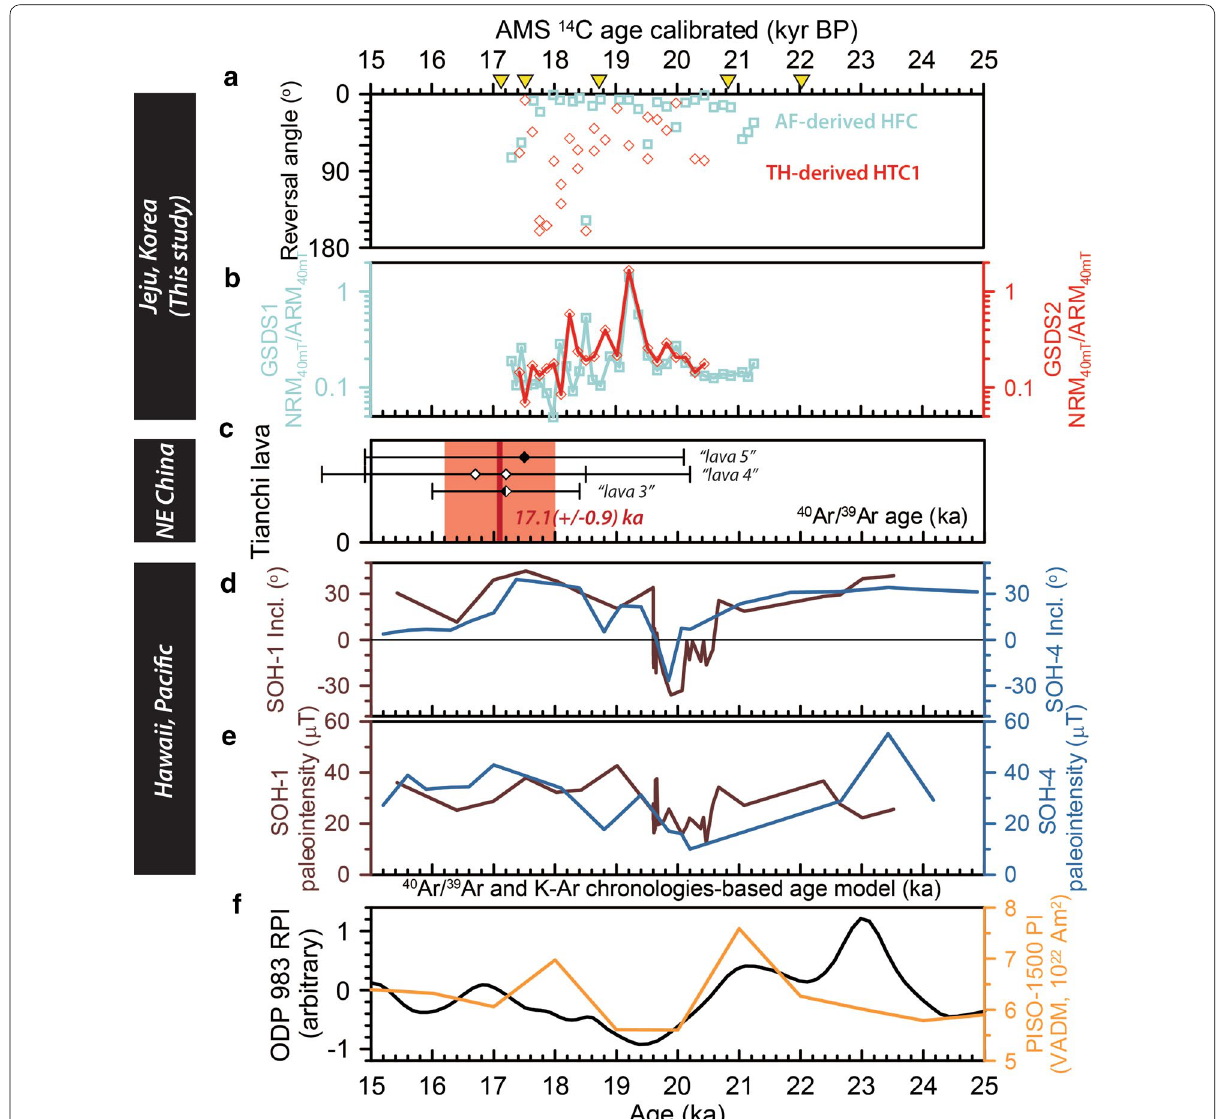
Fig. 13 Comparison of paleomagnetic data with anomalous directional features during 15–25 ka between the GSDS site (this study) and other dif‑ ferent sites. a The GSDS1‑AF‑derived HFC and the GSDS2‑TH‑derived HTC1 directional changes, expressed as the reversal angle (the angle between the paleomagnetic direction and the direction of today’s axial dipole field at the GSDS site) through time with our inferred age‑depth model. Yellow reversed triangles indicate AMS 14 C dates directly determined by Lim et al. (2015). b NRM 40mT /ARM 40mT ratio (possible RPI proxy) variations through time with our inferred age‑depth model in the GSDS site. c 40 Ar/ 39 Ar chronologies with the weighted mean of 17.1 0.9 (2 σ ) ka (a red line and ± box) by Singer et al. (2014b) from the Tianchi comenditic lava sequence where both excursional directions and low absolute paleointensities were reported by Zhu et al. (2000). The individual age data, with 2 σ uncertainties (error bars), are shown as open, half‑filled, and filled diamond sym‑ bols indicating reversed, transitional, and normal polarities, respectively. d , e Temporal variations of paleomagnetic inclination and paleointensity retrieved from SOH‑1 (brown lines; Teanby et al. 2002) and SOH‑4 cores (blue lines; Laj et al. 2002b) in Hawaii, with their proposed 40 Ar/ 39 Ar and K–Ar chronologies‑based age models. f Available time‑dependent RPI records, with a δ 18 O correlation‑based age model, from ODP site 983 (Gardar Drift, North Atlantic) (Channell et al. 1997) and the PISO‑1500 global RPI stack (Channell et al. 2009), as reference RPI